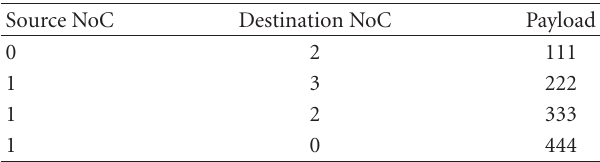
Table 6: The payload successfully reached to its desired destination Table 7: Initial source and destination information used to set up communication between